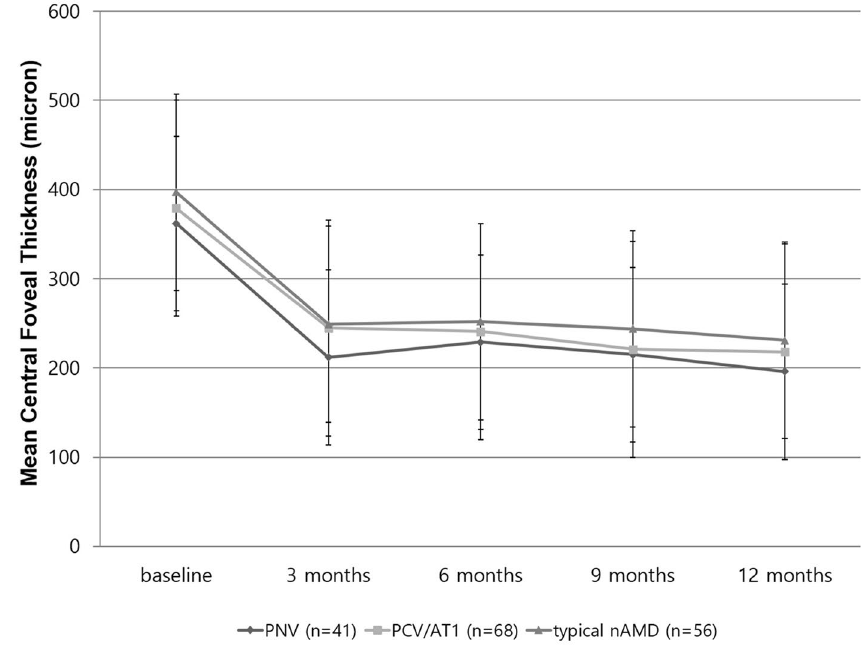
Figure 3. Changes in mean central foveal thickness during the 36-month anti-vascular endothelial growth factor treatment for pachychoroid neovasculopathy (PNV), polypoidal choroidal vasculopathy/aneurysmal type 1 neovascularization (PCV/AT1), and typical neovascular age-related macular degeneration (nAMD). The mean central foveal thickness showed a significant decrease when comparing from baseline through the 36 months follow-up for the groups. However, there was no significant difference between the groups in central foveal thickness at 3, 12, 24, and 36